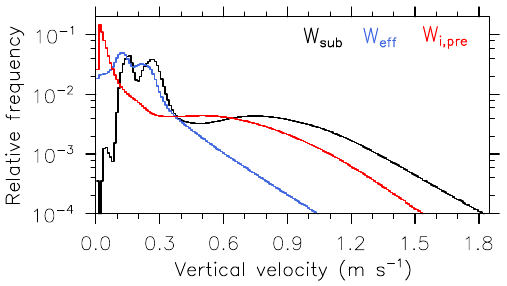
Figure 6. Probability distribution frequency (PDF) of sub-grid up- draft velocity ( W sub , black), effective updraft velocity ( W eff , blue) and vertical velocity reduction caused by PREICE ( W i , pre , red) from the Preice experiment. Model results are sampled every 3h. Only homogeneous ice nucleation occurrence events ( W eff >0) are